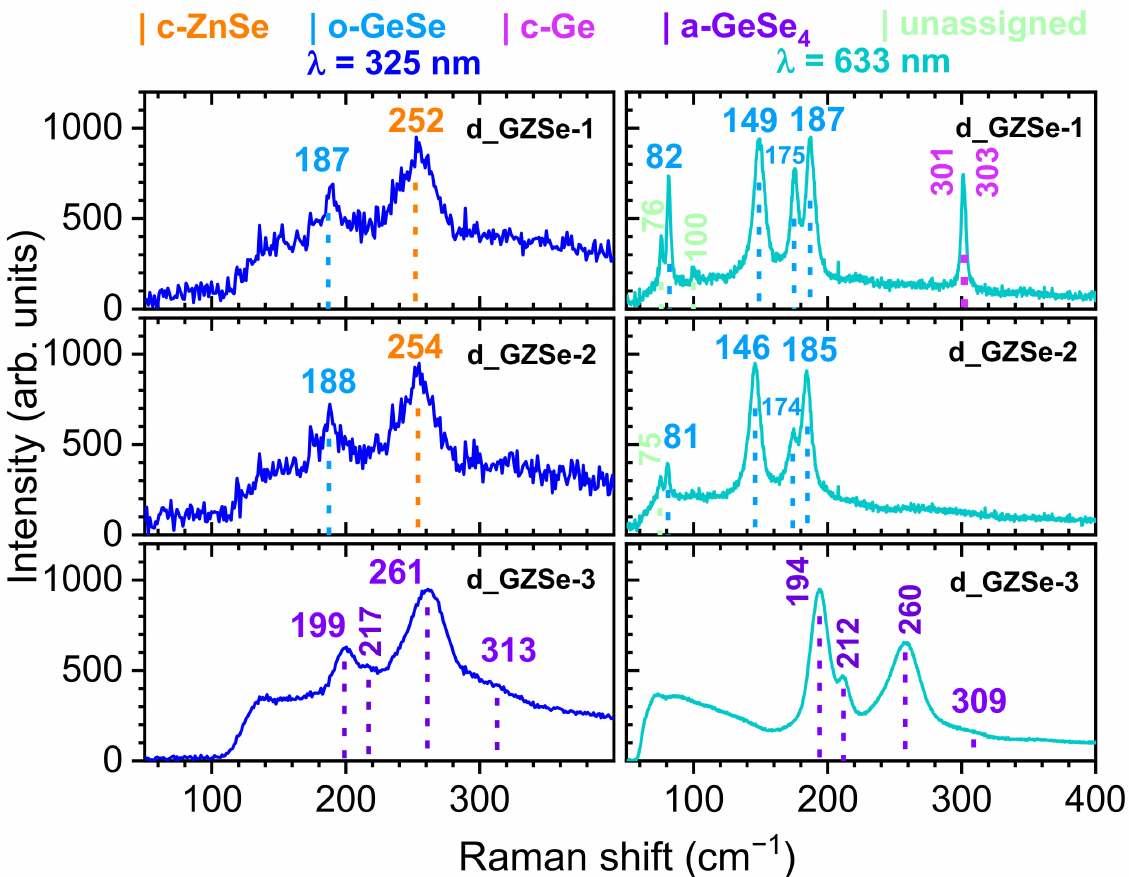
Figure 5. Micro-Raman spectra for the three bulk samples, when irradiated with monochromatic radiation with a wavelength of 325 nm ( left ) and 633 nm ( right ),